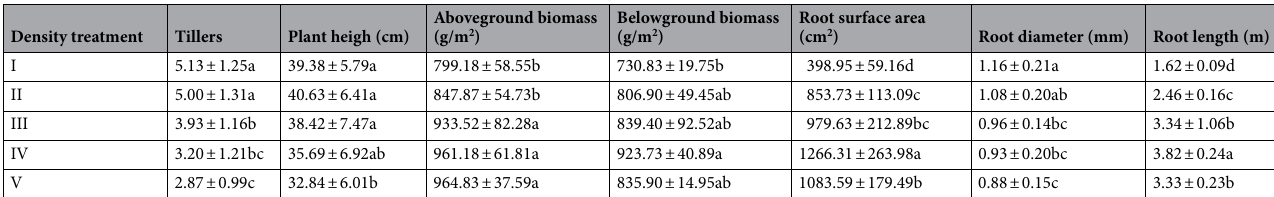
Table 1. Physiological characteristics of E. nutans under different plant density